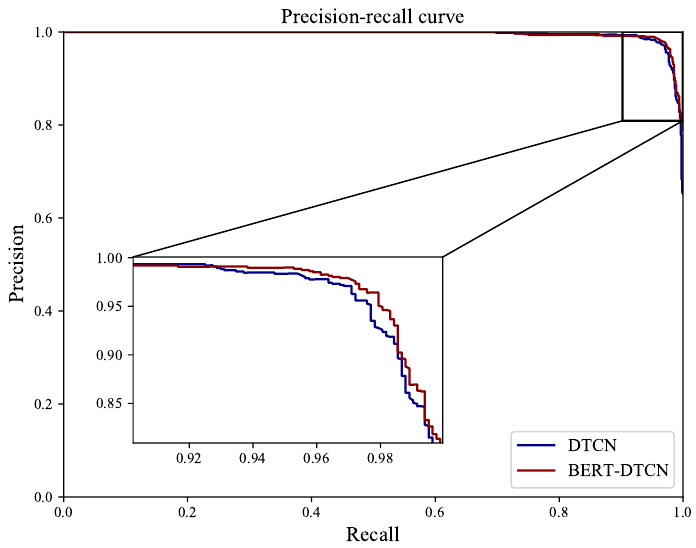
Figure 10. The ROC curves for DTCN and BERT-DTCN.